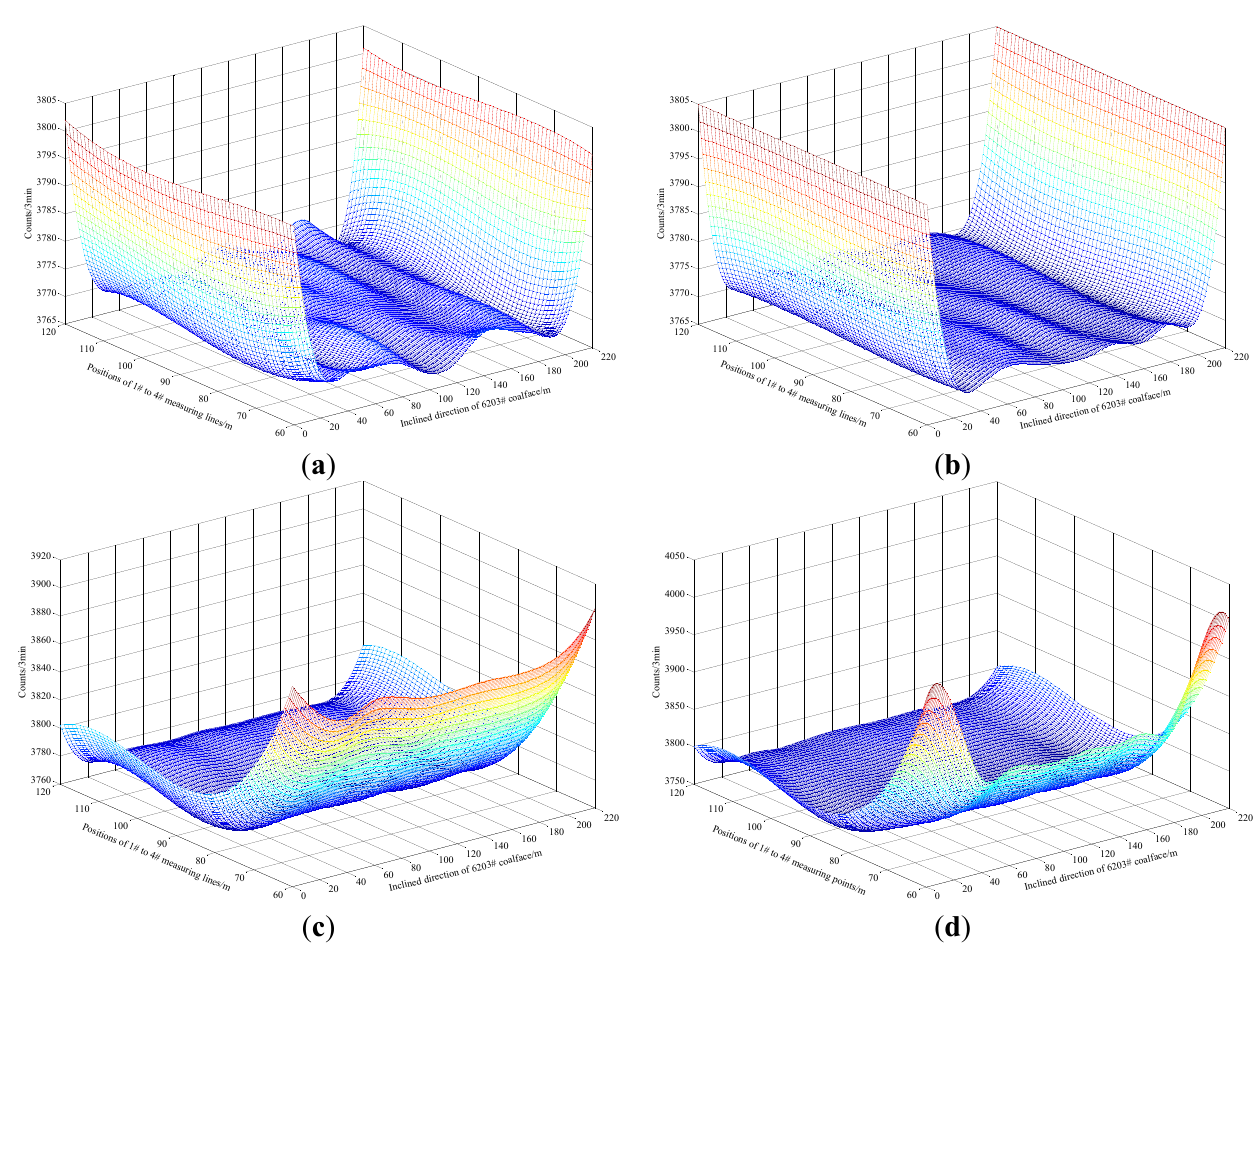
Figure 13. Variation features of the radon counts of ML 1 through 4: ( a ) 25 July; ( b ) 26 July; ( c ) 27 July; ( d ) 28 July; ( e ) 29 July; ( f ) 30 July; ( g ) 31 July; ( h ) 1